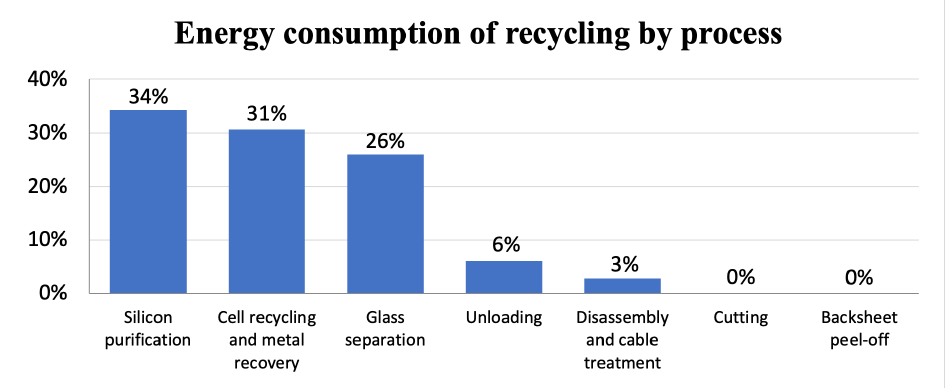
Figure 5. Energy consumption of recycling